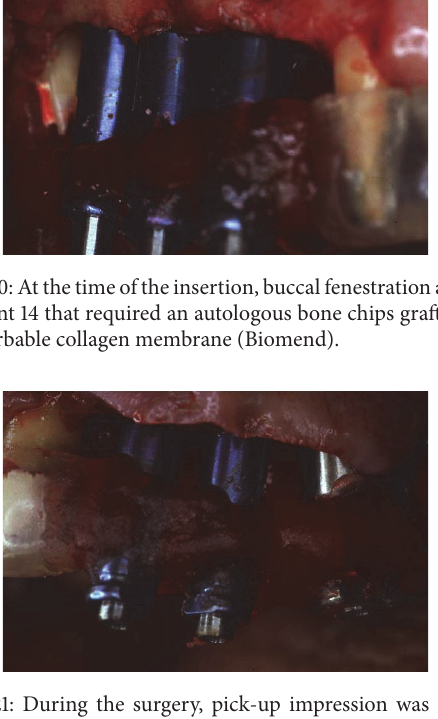
Figure 21: During the surgery, pick-up impression was taken by connecting the implant mounts to the modified surgical stents with a self-polymerizing acrylic resin (Duralay).